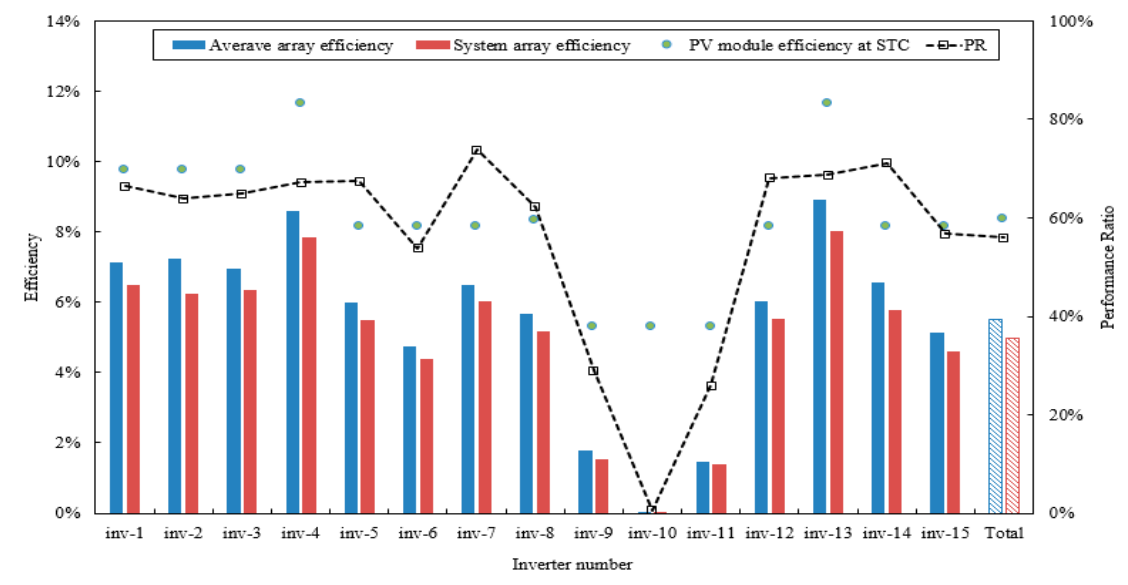
Figure 14. PV power generation efficiency and PR by 5 year average (2013 – 2017).